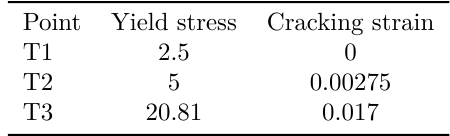
Table 3. TRC plastic tensile constitutive